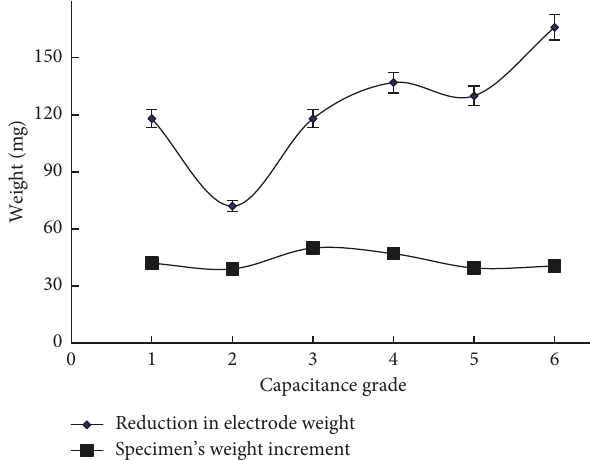
Figure 7: Effect of capacitance on the electrode and the specimen’s weight variation (the volume ratio of h-BN to Cu is 19%, and deposition time is